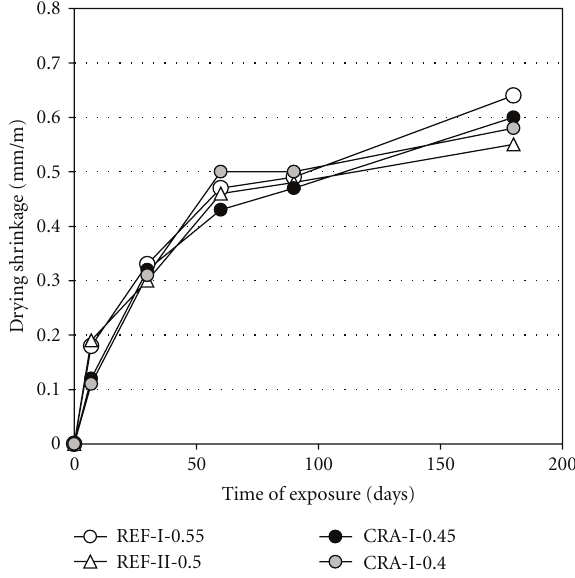
Figure 4: Drying shrinkage versus time of exposure for C 32/40 strength class